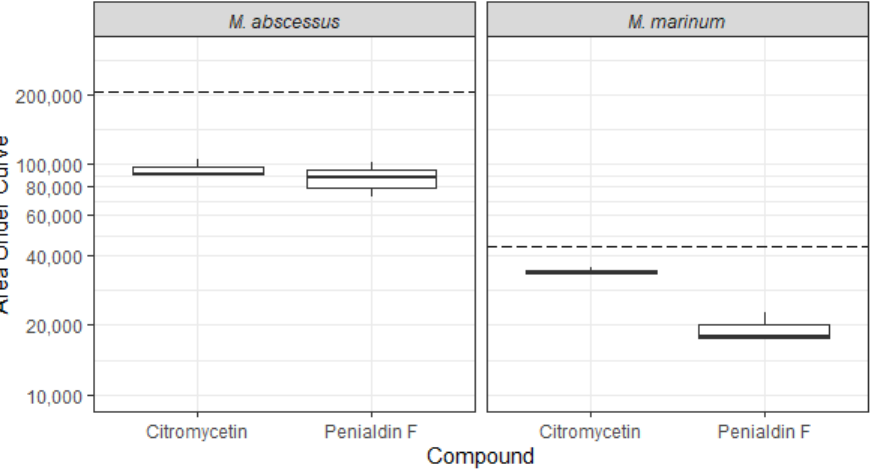
Figure 6. Effect of citromycetin ( 2 ) and penialdin F ( 4 ) on the luminescence of Mycobacterium abscessus BSG301 and M. marinum BSG101. The antibacterial activity of citromycetin ( 2 ) and penialdin F ( 4 ) were measured by changes in bacterial luminescence. Data are presented as box and whisker plots of the area under the curve values calculated from lumines- cence readings taken over 72 h. Boxes are upper and lower quartiles with median shown. The whiskers extend up to 1.5 × the inter-quartile range. The dotted line represents the no-compound control.